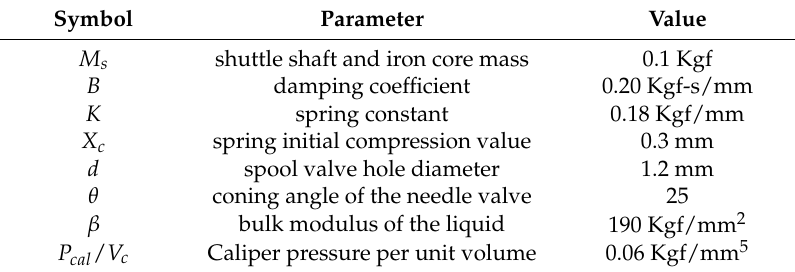
Table 3. The PEHB model